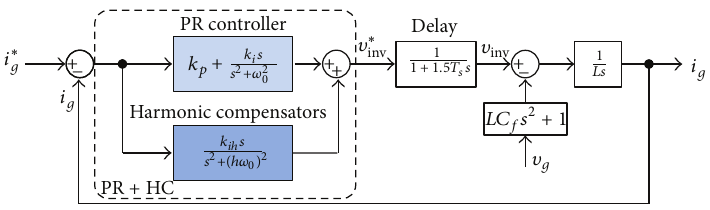
Figure 9: Current control loop with PR controller and harmonic compensation to eliminate harmonic voltage distortion.